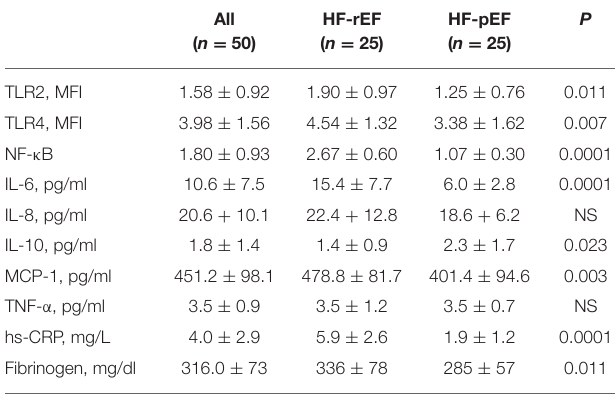
TABLE 2 | Inflammatory parameters of the whole study population and of the two groups separately.